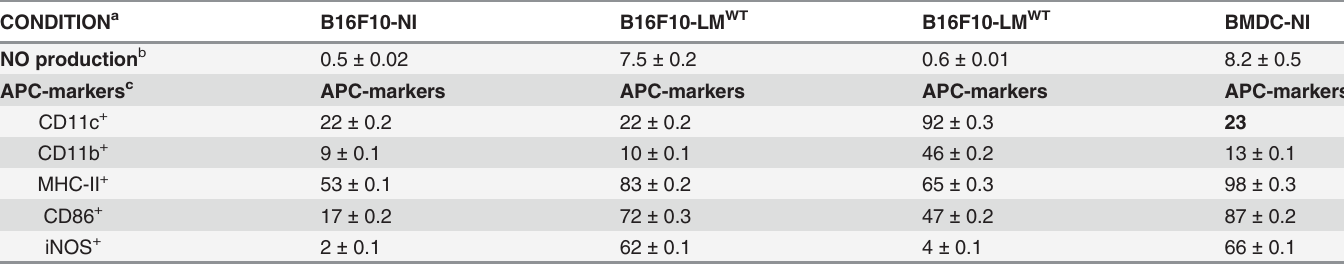
Table 1. Listeria infection of melanoma induces nitric oxide and iNOS